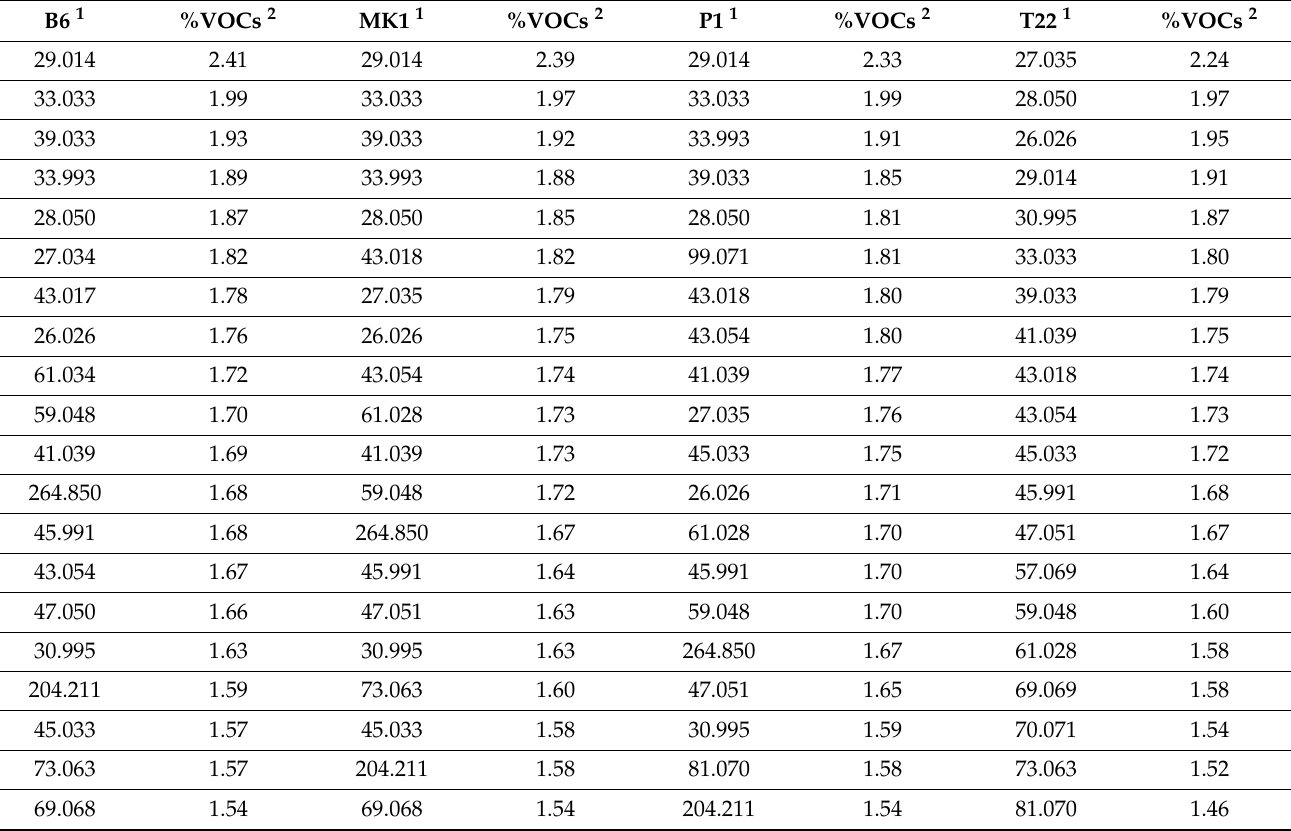
Table 2. Emissions of the Top 20 VOCs of Trichoderma species grown in